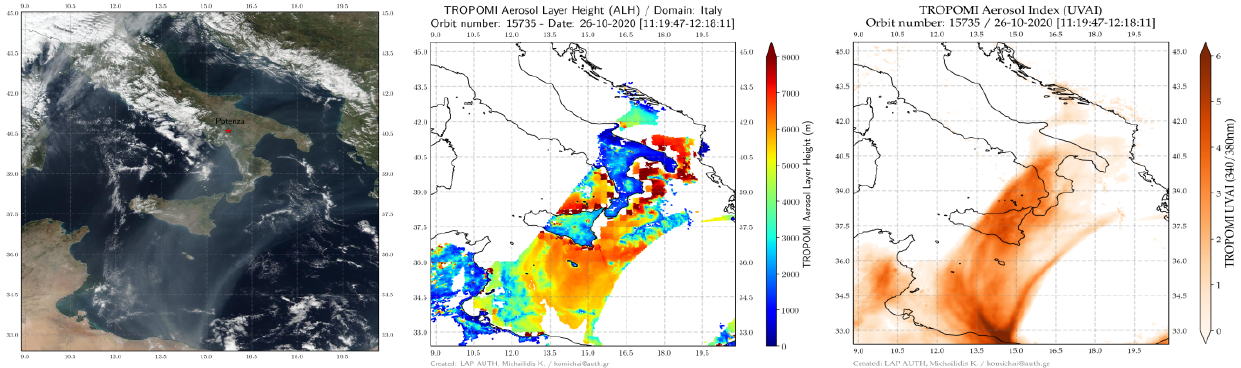
Figure 12. VIIRS Suomi-NPP true-colour image of 26 October 2020 over the central Mediterranean capturing the smoke plume (left). The red star indicates the position of the Potenza lidar station. TROPOMI ALH (middle) and UVAI (right) retrievals. Missing ALH pixels are flagged by a cloud or have negative AI values.